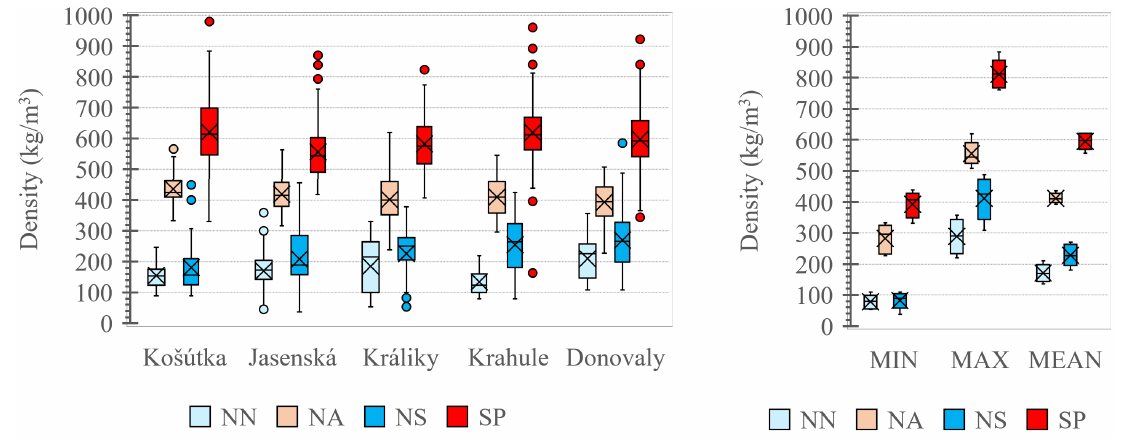
Figure 4. ( a ) Comparison of the data for three seasons with regard to the snow density of new natural snow (NN), new artificial snow (NA), uncompacted natural snow (NS), and ski piste snow (SP) for the five ski centers. The lowest number of measured samples (N = 30) was in the case of NA in Kraíliky and NN in Krahule. Description of boxplot: cross = mean, horizontal line in the box = median, box = 50% of values, box with whiskers = 99% of values, points = outliers. ( b ) Boxplots of the minimal, maximal, and mean density identified in each of five ski centers (excluding outliers) over the three winter seasons for four snow types ( n = 5).